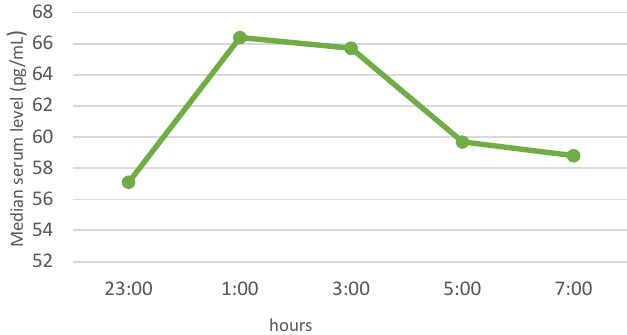
Figure 3. Night profile of obestatin in the study group.